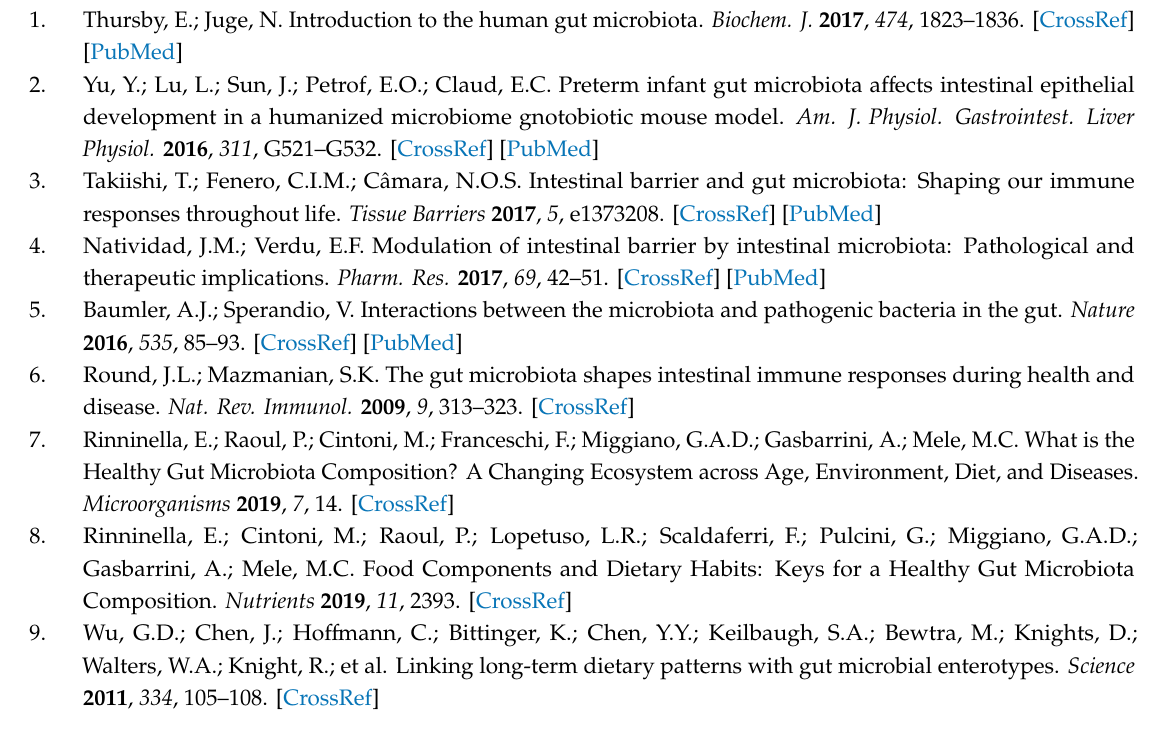
Figure S1: Gut microbiota of the subjects at the genus level. Abundance rates of bacteria identified at the genus level and detected in ≥ 20% of subjects are